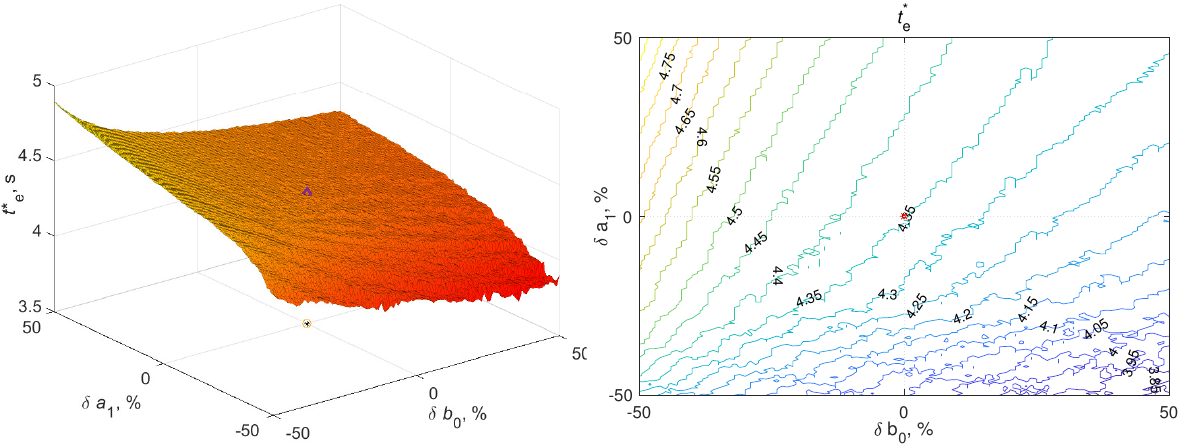
Figure 15. Simulations results. Dependence of t ∗ e on plant model parameters a 1 , b 0 , varying on ± 50 %; γ = 1000, γ I = 500, ω ∗ = 60 rad/s, ψ ∗ = π . Left : 3D plot, right : contour plot; asterisk (cid:63) is for “nominal” parameters.